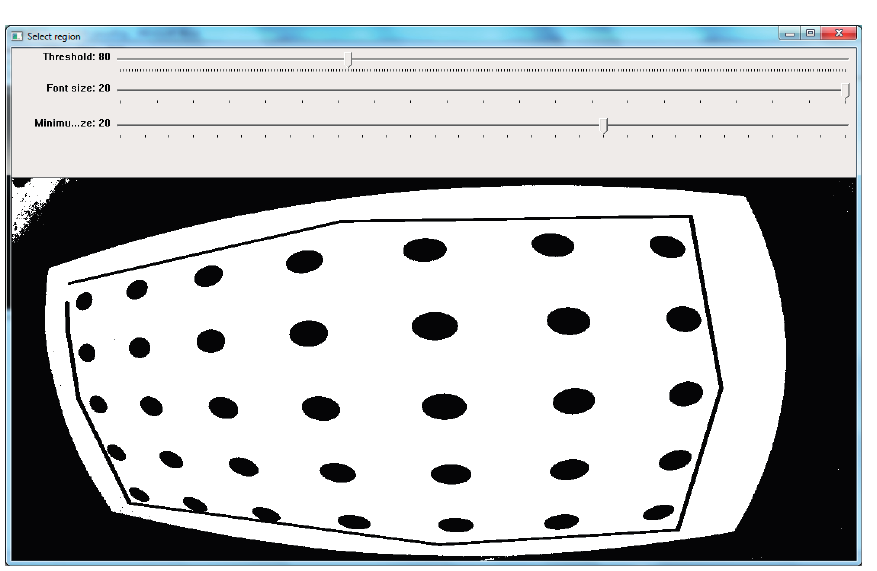
Figure 9. The user defines with the use of the sliders the parameters for the software and defines on the graphical window the region including the control points.